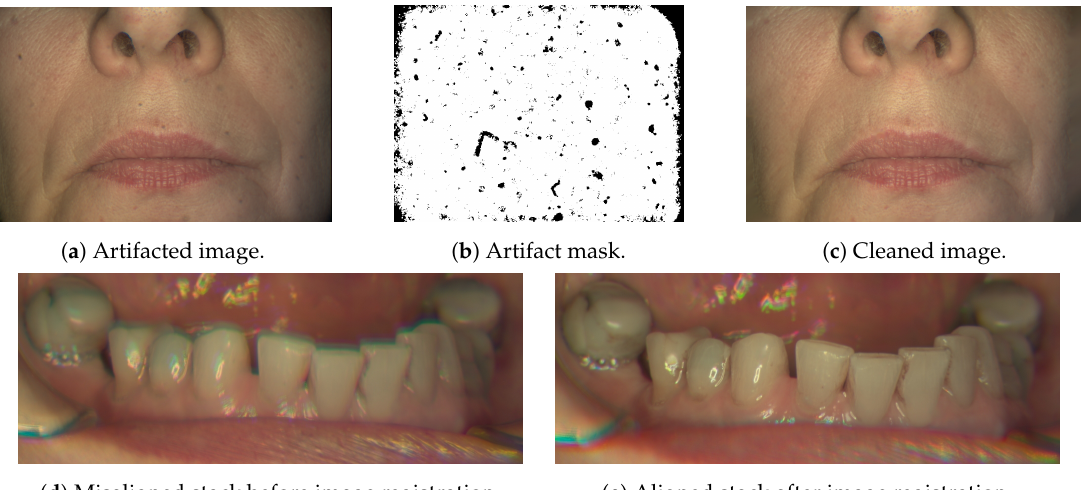
Figure 4. ( a – c ) Nuance EX dark artifact cleaning by digital inpainting and ( d – e ) the effect of involuntary movements before image